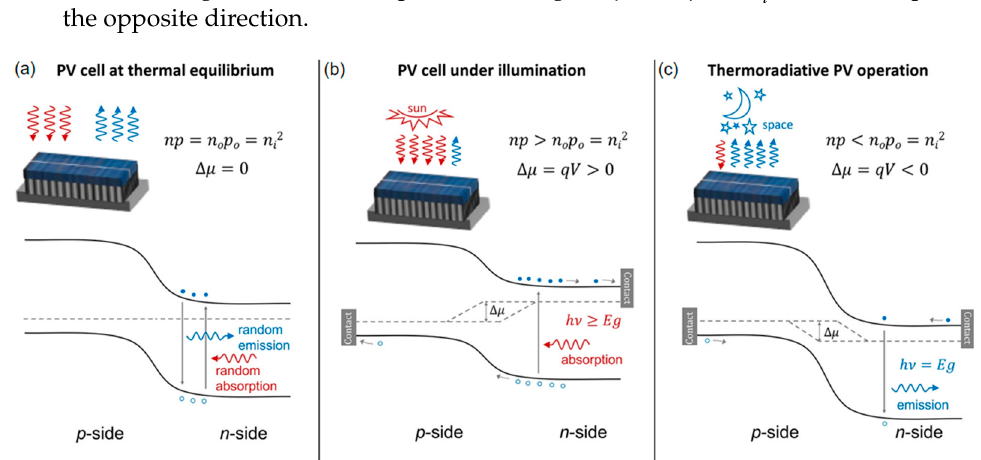
Figure 8. The band diagrams and the path of carriers for ( a ) PVCs at thermal equilibrium, ( b ) PVCs under illumination, and ( c ) TRC operation. Reprinted with permission from [131]. Copyright 2020, American chemical society.